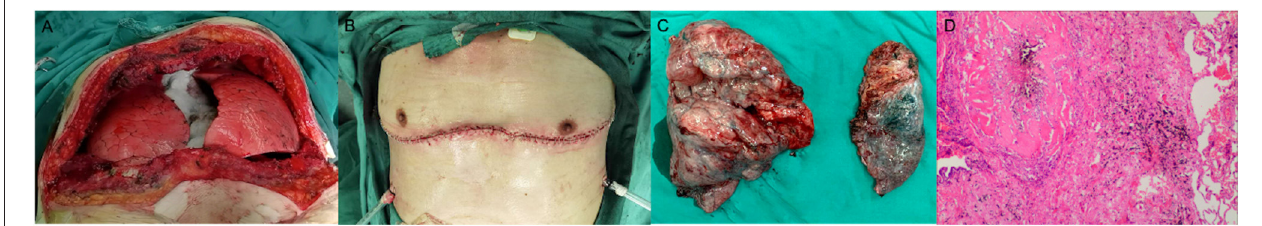
FIGURE 1 | Surgical and pathological images of patient 1. (A) The mediastinum was restored after the release of mediastinal adhesions, and the sizes of the bilaterally transplanted lungs were moderate, which were consistent with the size of the recipient’s chest. (B) The operation was performed in the supine position with a clam-shell incision along the 4th intercostal space. (C) A surgical specimen of the recipient’s lungs. Note the significant compensatory enlargement of the recipient’s right lung (left) and the damaged left lung (right). (D) Postoperative pathological examination showed silicosis nodules and silica dust particle deposition.